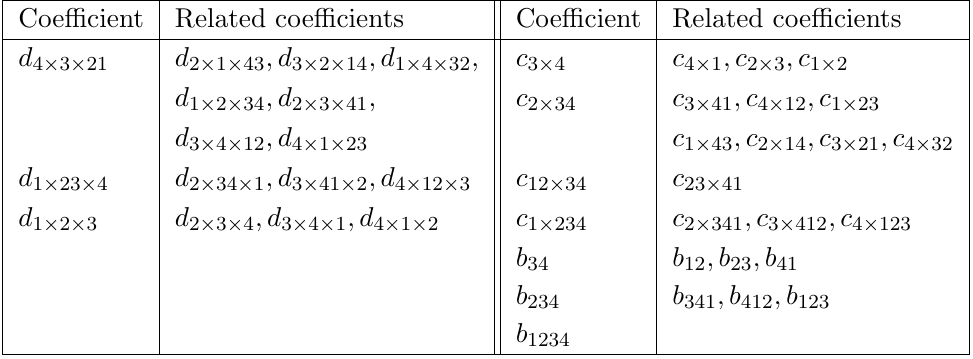
2 (cid:0) 3 + 4 (cid:0) g g g g